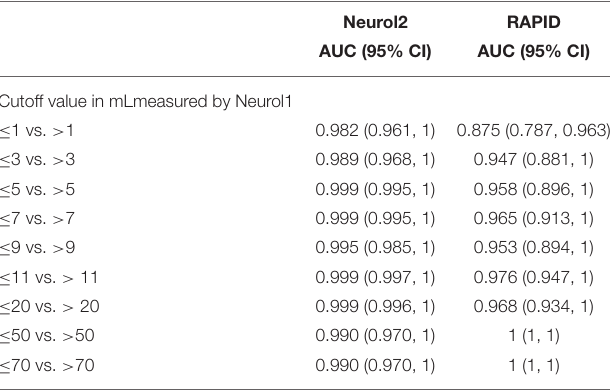
TABLE 2 | Areas under the curve (AUC) of receiver operated curves at different stroke volumes for supratentorial stroke volumes with neurologist1 as reference.